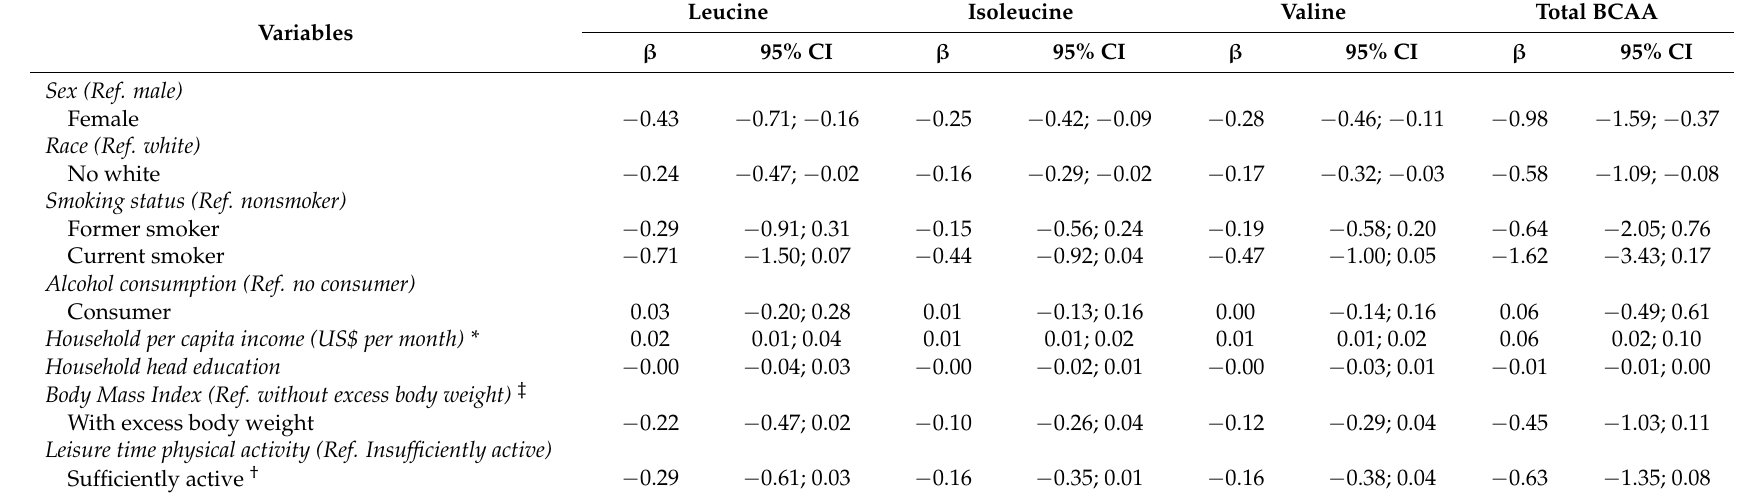
Table 1. Demographic, socioeconomic and lifestyle factors associated with branched chain amino acid intake in adolescents, ISA Capital, Sao Paulo, Brazil, 2008.